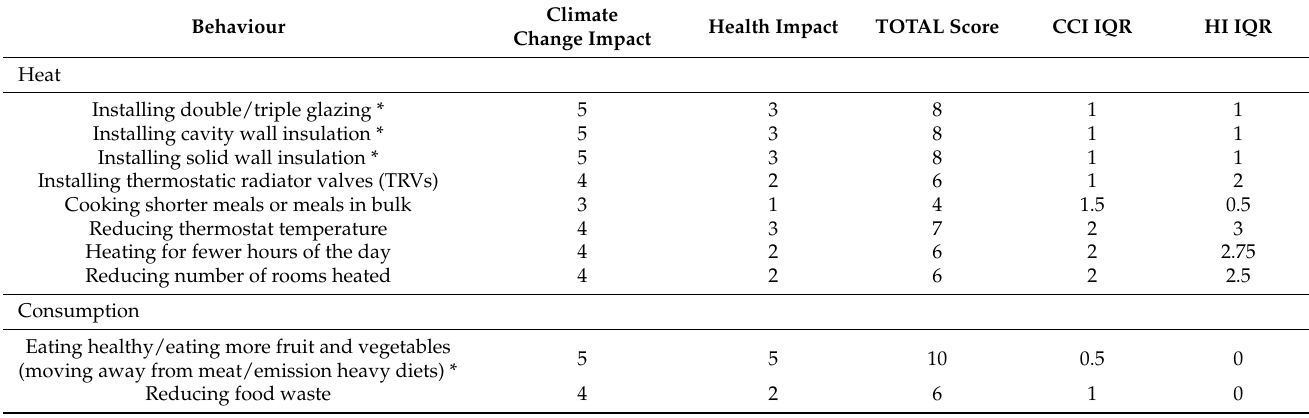
Table 2. Climate change mitigation behaviours that achieved and did not achieve consensus in Round 2, climate change impact Likert importance scores, health impact criteria Likert importance scores, cumulative importance scores (TOTAL score), climate change impact IQR values (CCI IQR) and health impact IQR values (HI